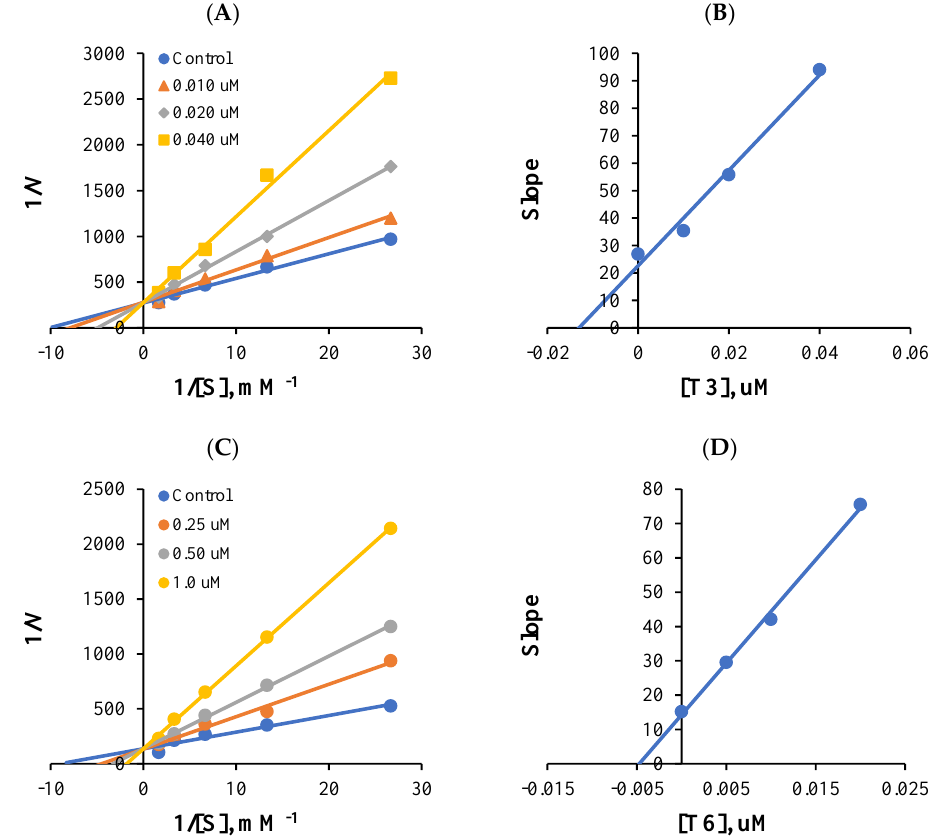
Figure 2. Lineweaver-Burk plots for MAO-B inhibition by T3 or T6 ( A , C ), and respective secondary plots ( B , D ) of slopes vs. inhibitor concentrations.